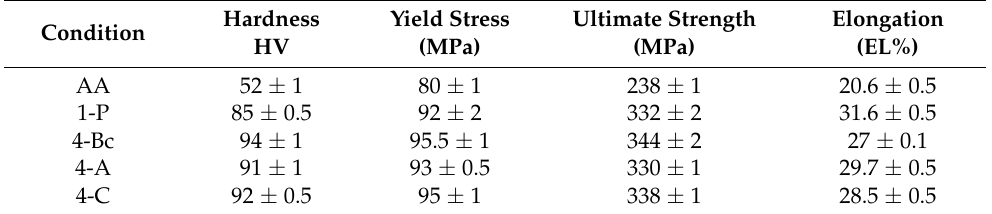
Table 4. Hardness values and the tensile properties of ZK30 billets before and after ECAP processing. Condition